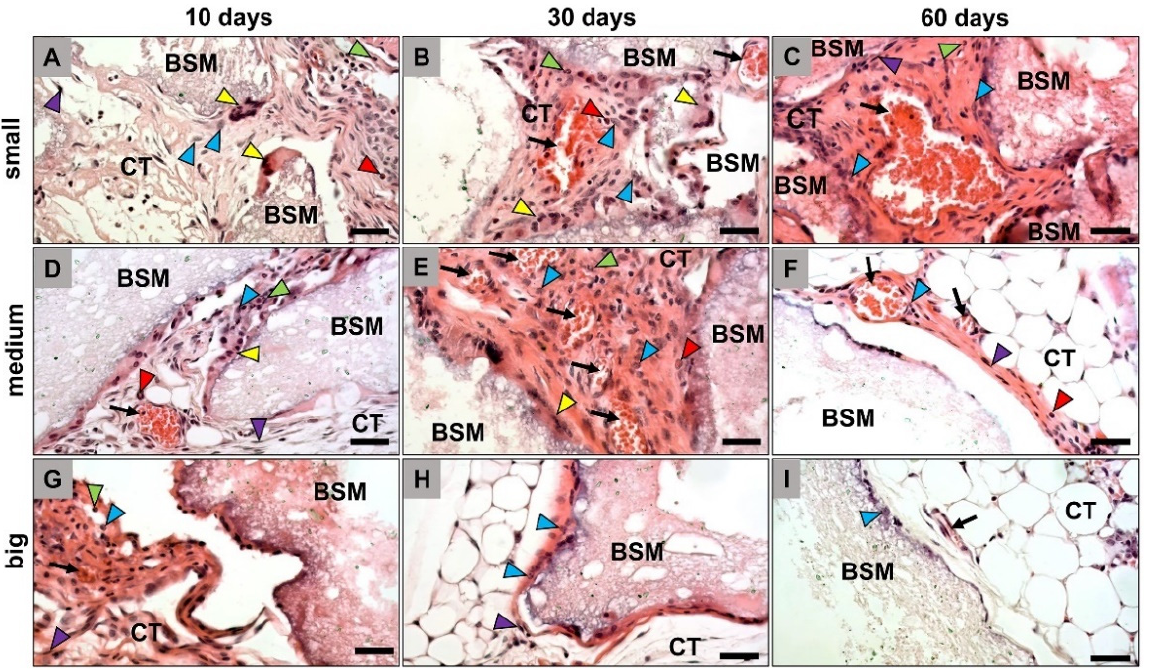
Figure 1. Exemplary histological images of the tissue reactions to the differently sized bone substitute materials (BSM), i.e., the small BSM granules ( A – C ), the medium-sized BSM granules ( D – F ), and the big BSM granules ( G – I ). CT = connective tissue, blue arrowheads = macrophages, yellow arrowheads = multinucleated giant cells, purple arrowheads = fibroblasts, red arrowheads = eosinophils, green arrowheads = neutrophils, black arrows = blood vessels (HE-staining, 400 × magnifications, scalebars = 50 µm).